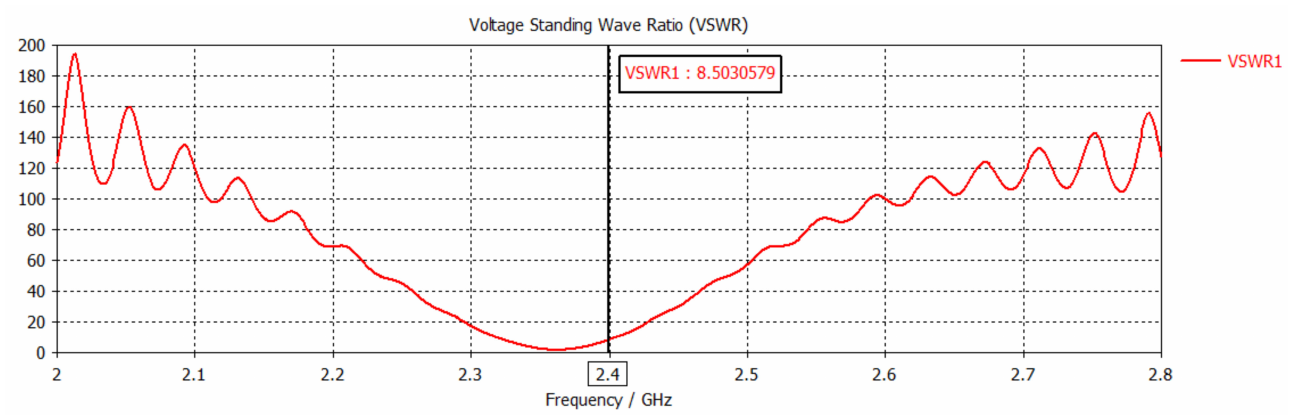
Figure 13. VSWR by frequency in patch antenna of 2.4 GHz with line transmission λ